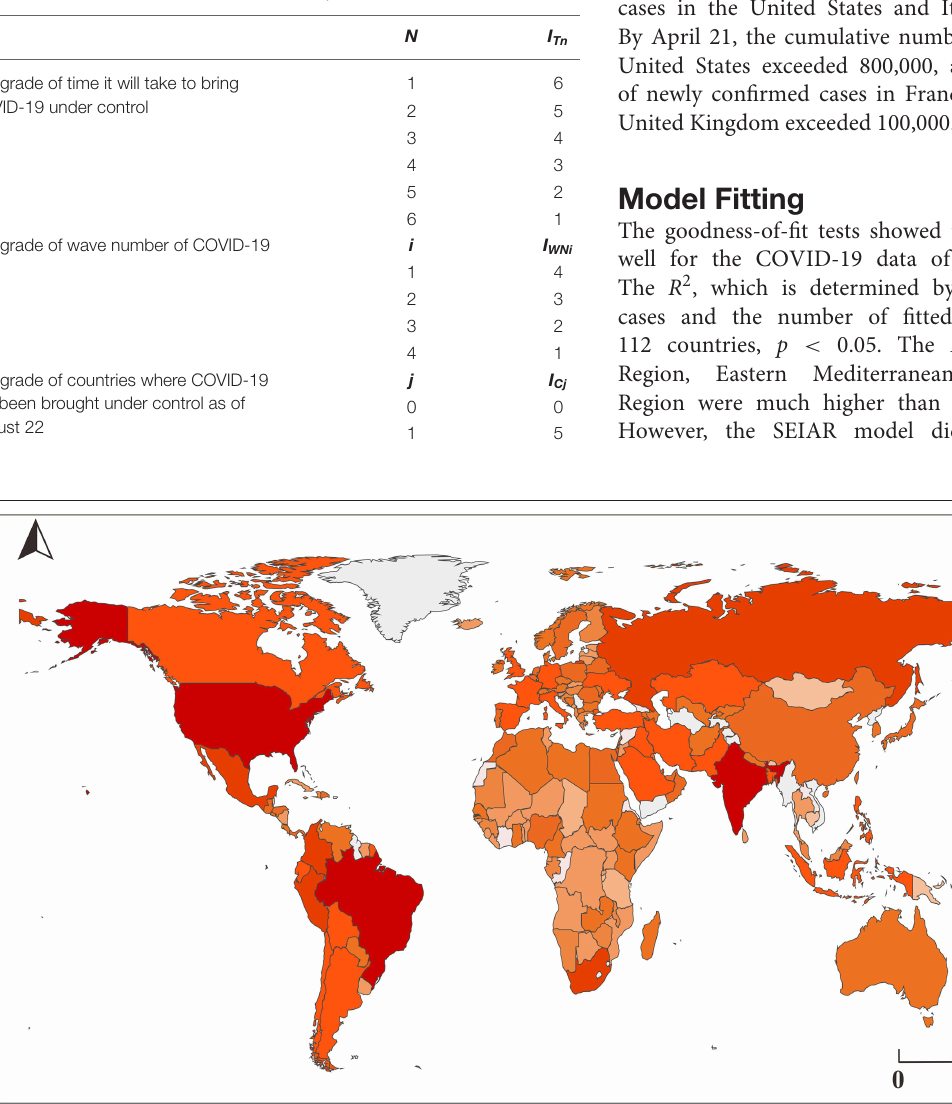
TABLE 2 | The specific values of I Tn , I WNi , and I Cj .